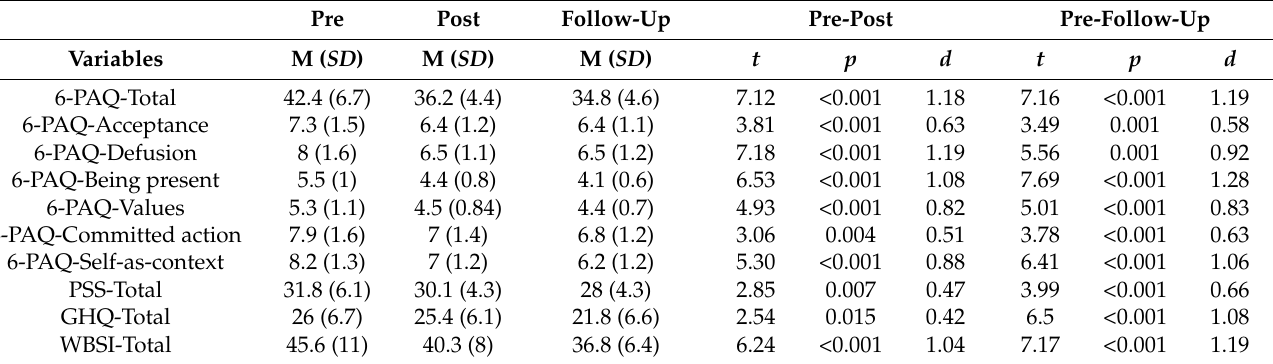
Table 2. Questionnaire scores and effect comparisons in the clinical